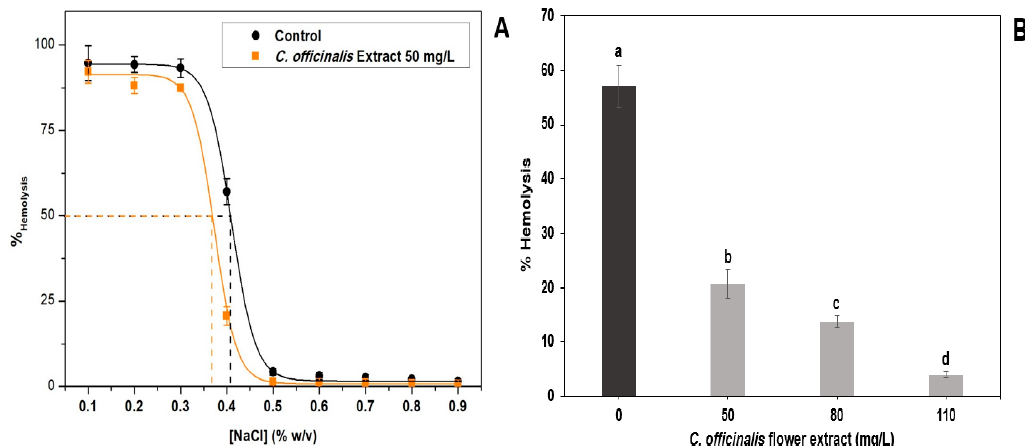
Figure 2. In vitro antihemolytic effect of lyophilized marigold extract ( C. officinalis ). ( A ) Effects on hemolysis of human erythrocytes at different concentrations of NaCl; ( B ) effects of different extract concentrations on hemolysis of human erythrocytes at 0.3% (w/v) NaCl. Different letters (a–d) represent statistically significant differences, p < 0.0001 ( B ).